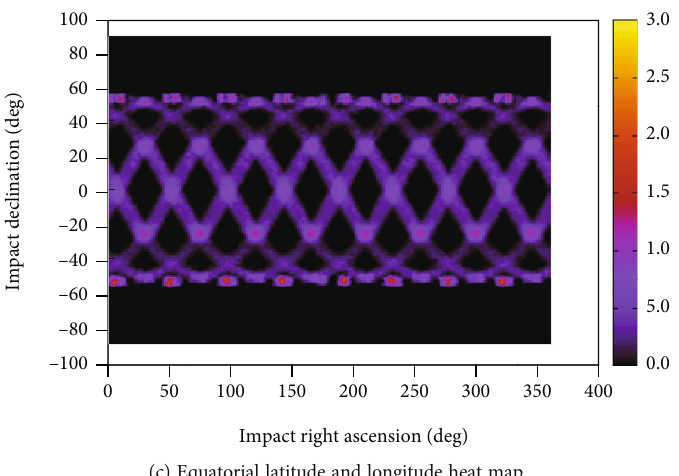
Figure 7: Longitude fl uxes and latitude fl uxes at impact sites.